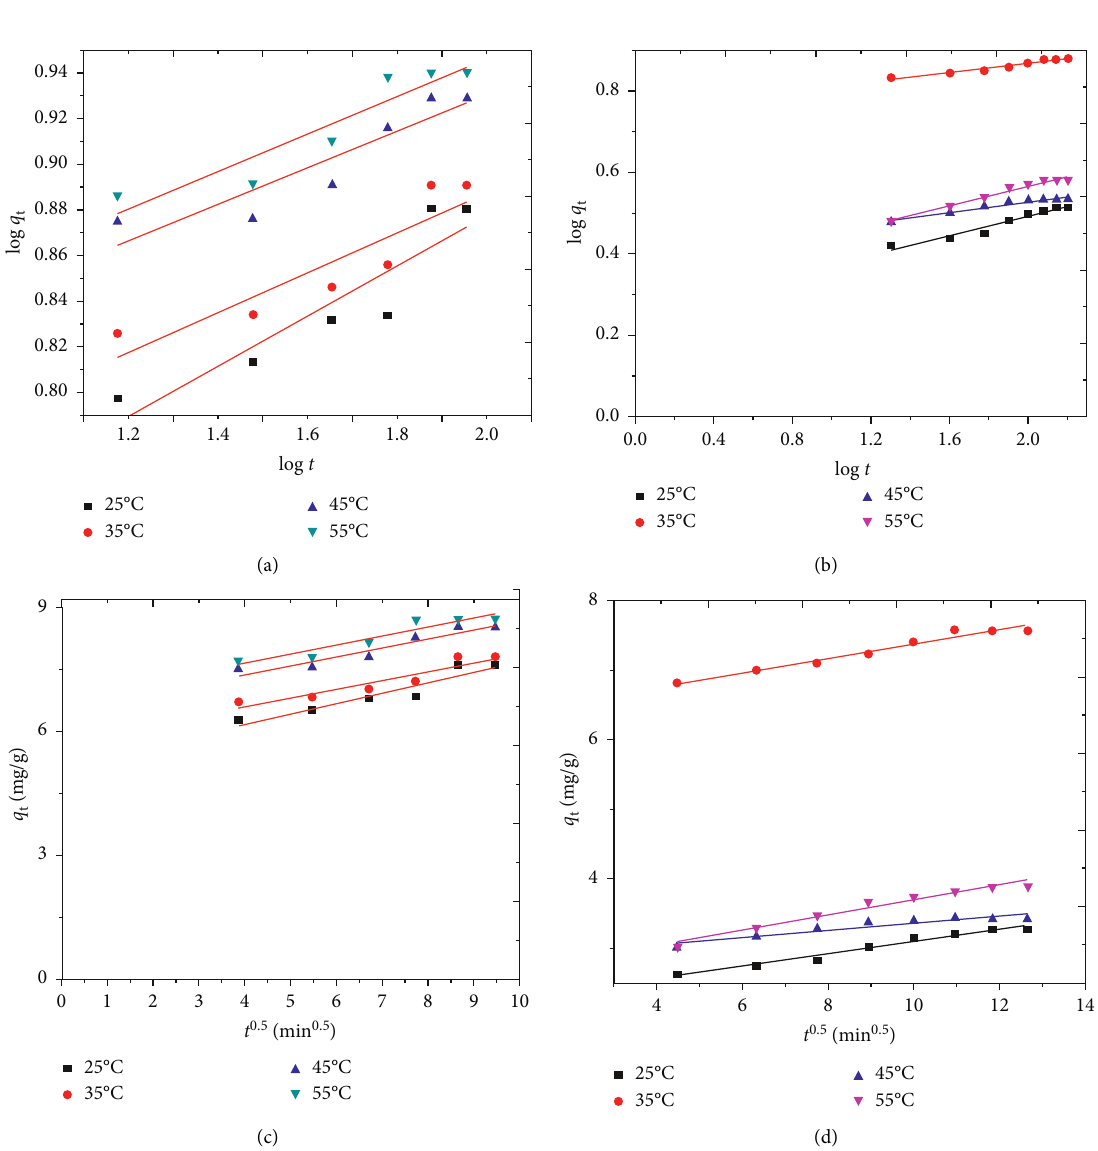
Figure 8: Bhangam kinetics of (a) CR and (b) SF; intraparticle diffusion kinetics of (c) CR and (d) SF.